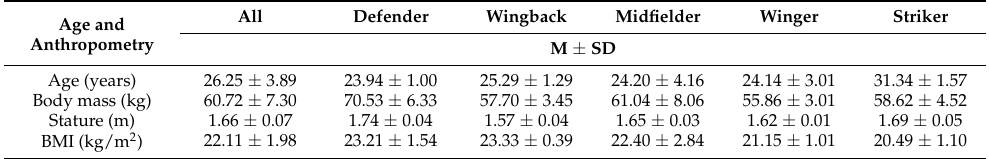
Table 1. Characteristics of the female players by specific